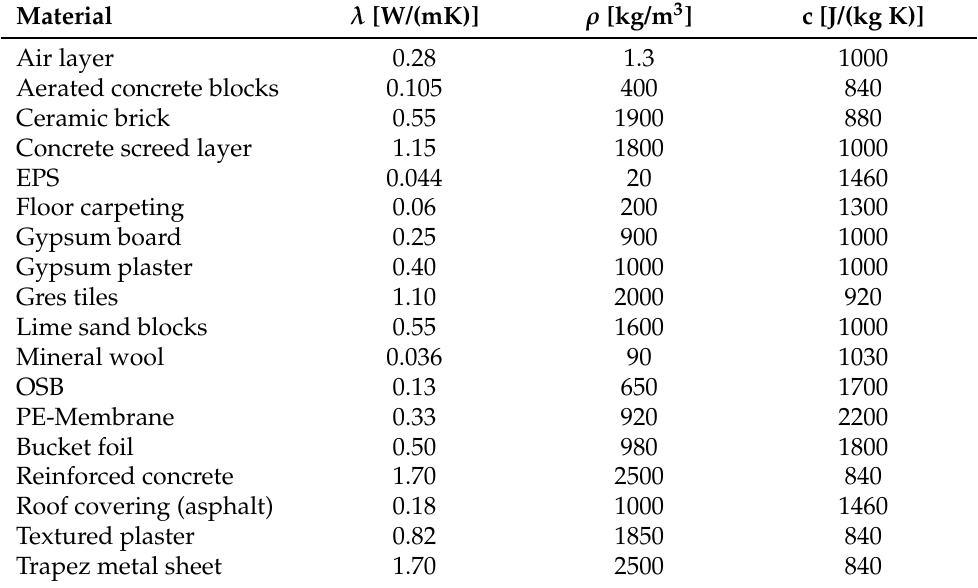
Table 2. Thermophysics properties of